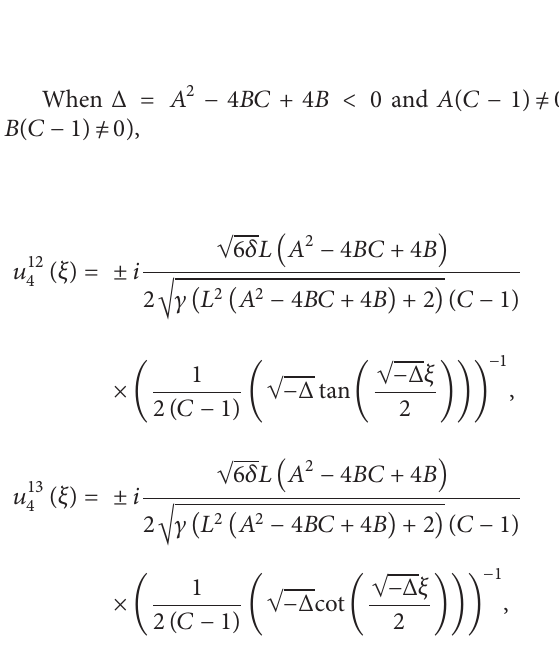
Figure 5: (a)–(d) show traveling wave solution for 𝑢 3 4 for different values of parameters.